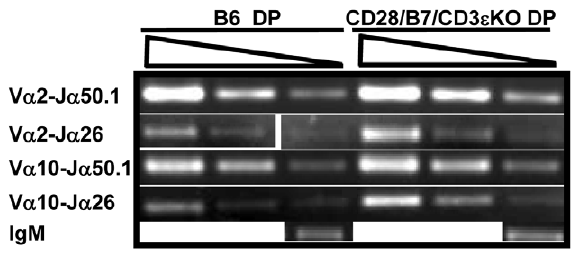
Figure 3. TCR a rearrangement is equivalent in DP cells generated via pre-TCR- or CD28/B7-dependent development. 300, 100, and 30 ng of DNA prepared from FCM sorted DP cells was analyzed by PCR to detect the indicated V a -J a rearrangements. The PCR reaction for unrearranged IgM was performed using 10 ng DNA. The results presented here comparing TCR a rearrangements in B6 and CD28/B7/CD3 e KO DP cells were analyzed in the same experiment and are representative of three experiments performed using DNA prepared from five to six B6 or CD28/B7/CD3 e KO mice.